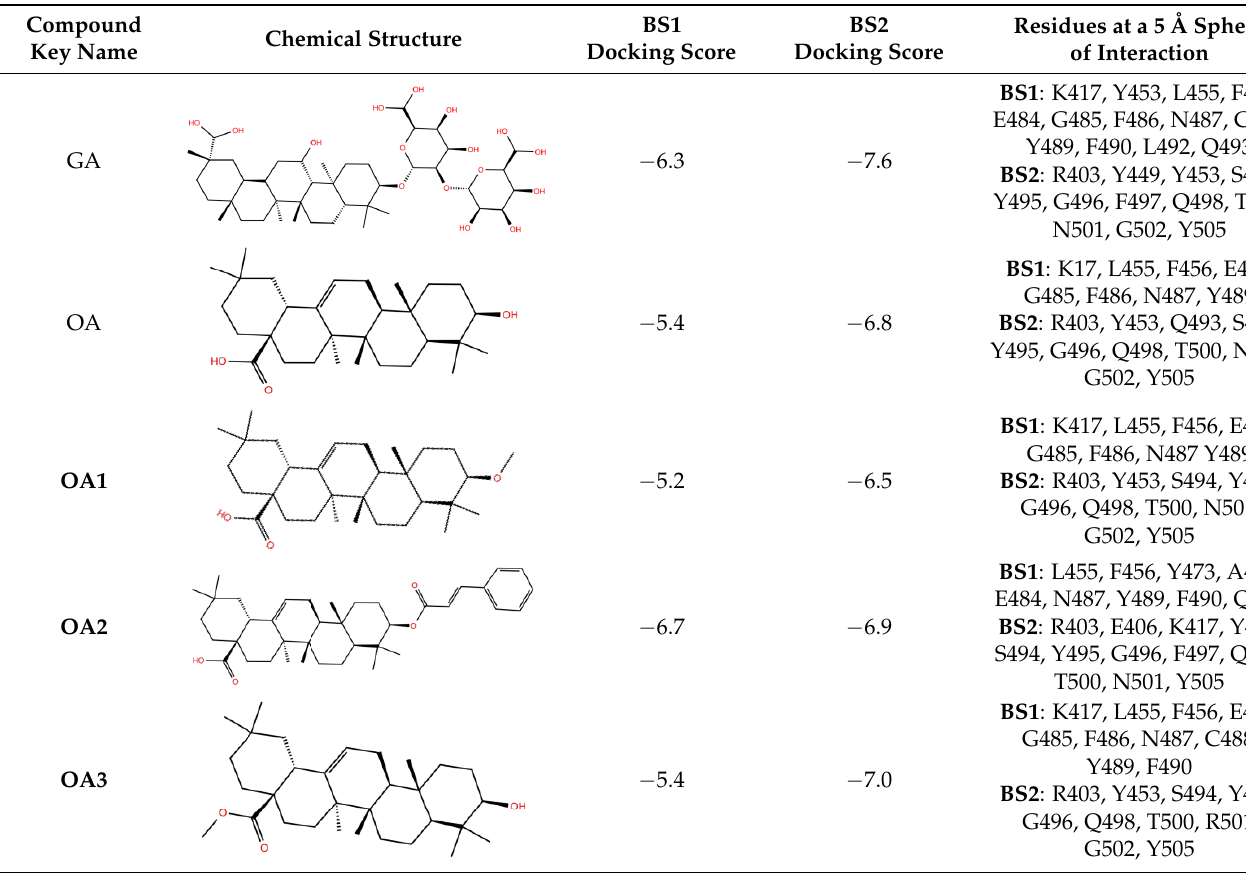
Table 1. Docking scores, interacting residues (5 Å cutoff) and chemical structure of the studied compounds and the reference compound (GA). Docking scores are reported in kcal/mol.